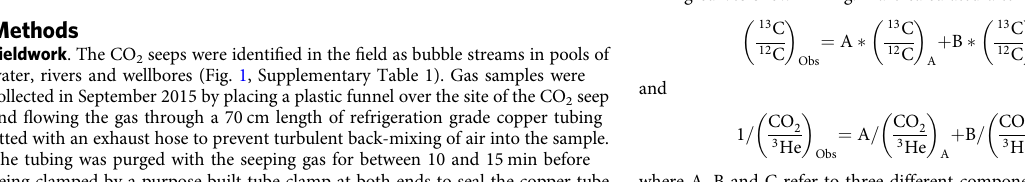
deep-sourced mantle volatiles.